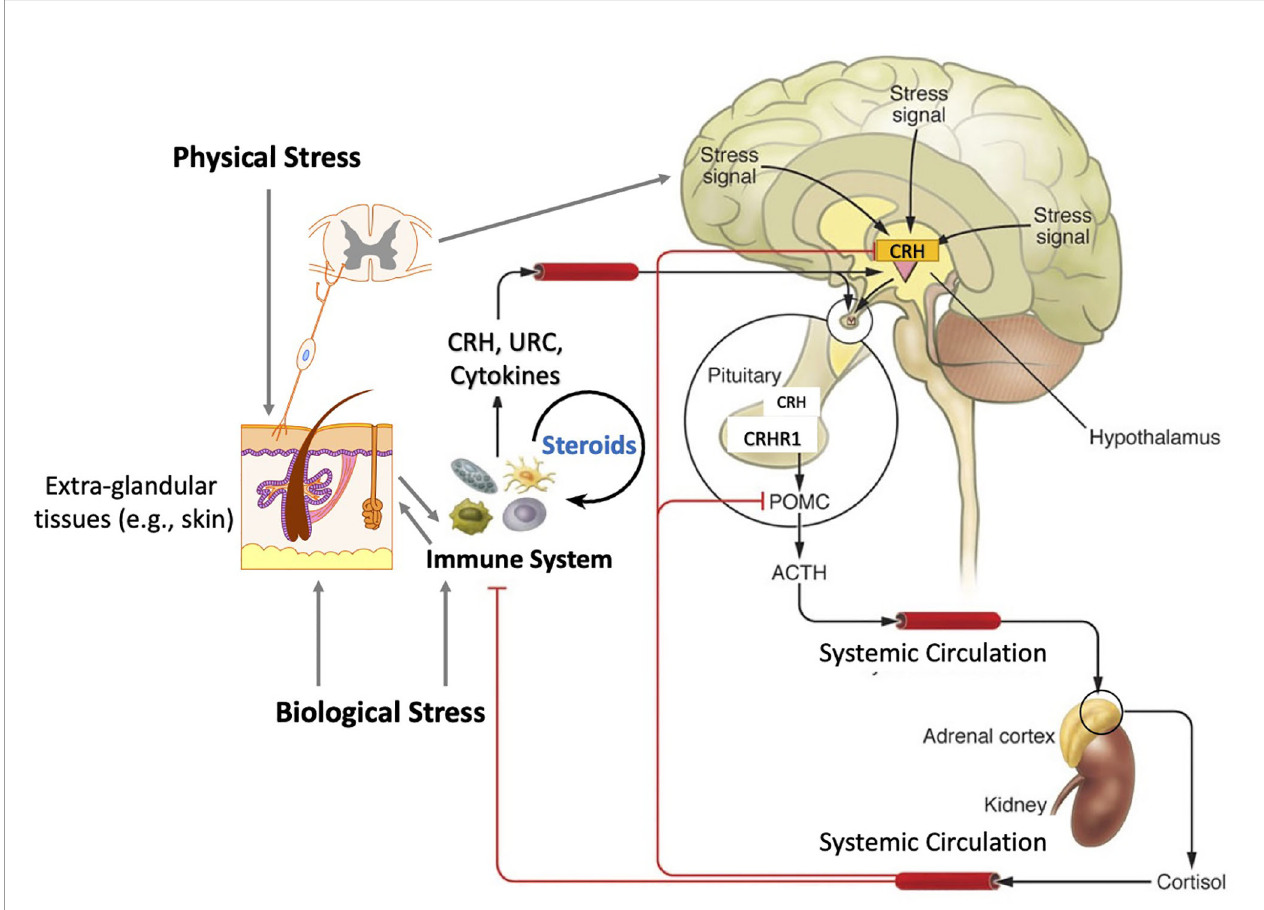
FIGURE 1 | The functional organization of the hypothalamic-pituitary-adrenal axis with inputs from the immune system and peripheral organs. Physical and biological stress promotes the release of stress signals in both the brain, the skin, and immune cells, resulting in the hypothalamic release of corticotropin releasing hormone (CRH), which in turn stimulates the release of adrenocorticotropic hormone (ACTH) and pro-opiomelanocortin (POMC) expression and processing in the anterior pituitary. ACTH binds to the melanocortin-2 (MC2) receptor in the zona fasciculata of the adrenal cortex and stimulates the transport of cholesterol into the mitochondria and stimulates the production cortisol. Glucocorticoids not only regulate body homeostasis but also act in a negative feedback loop for CRH and POMC expression. Immune cell-mediated steroidogenesis and secosteroidogenesis are emerging as new modes of immune regulation. Reprinted with permission from the (7,